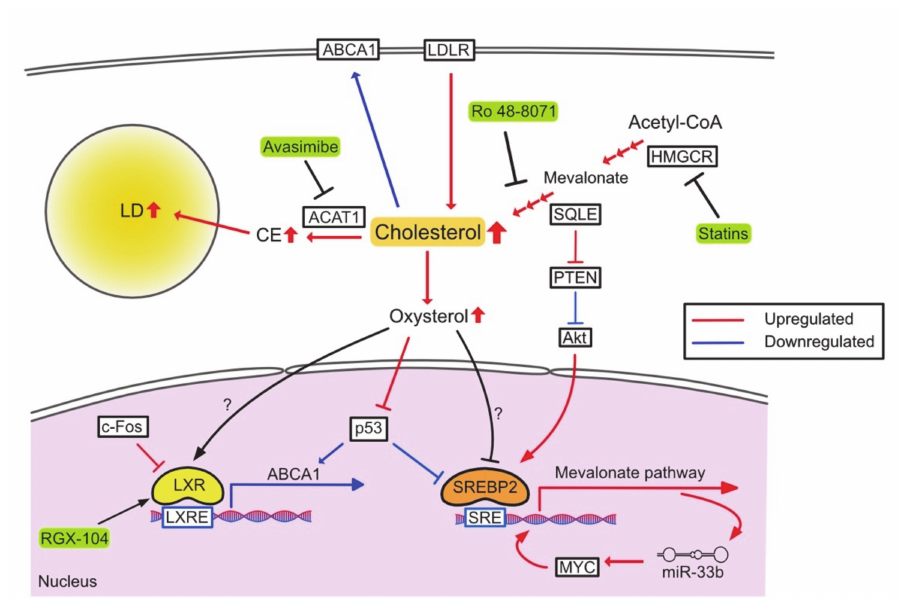
Figure 2. Reprogrammed cholesterol metabolism and therapeutic targets. PTEN, phosphatase and tensin homolog deleted from chromosome